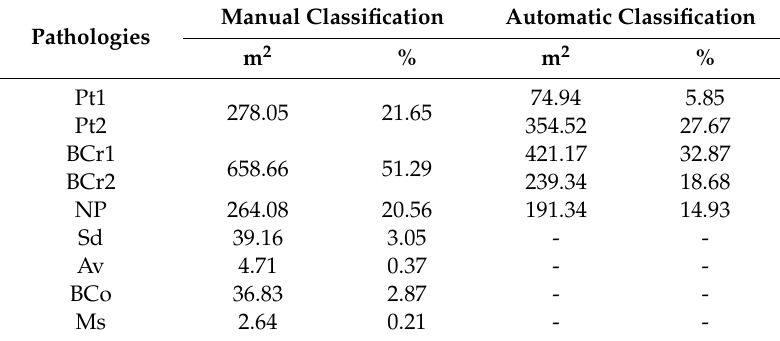
Table 4. Comparison of the areas occupied by each pathology. Pt1 = patina 1, Pt2 = patina 2; BCr1 = biogenic crusts 1; BCr2 = biogenic crusts 2; NP = no pathology; Sd = sanding; Av = alveolization; BCo = biologic colonization; Ms =